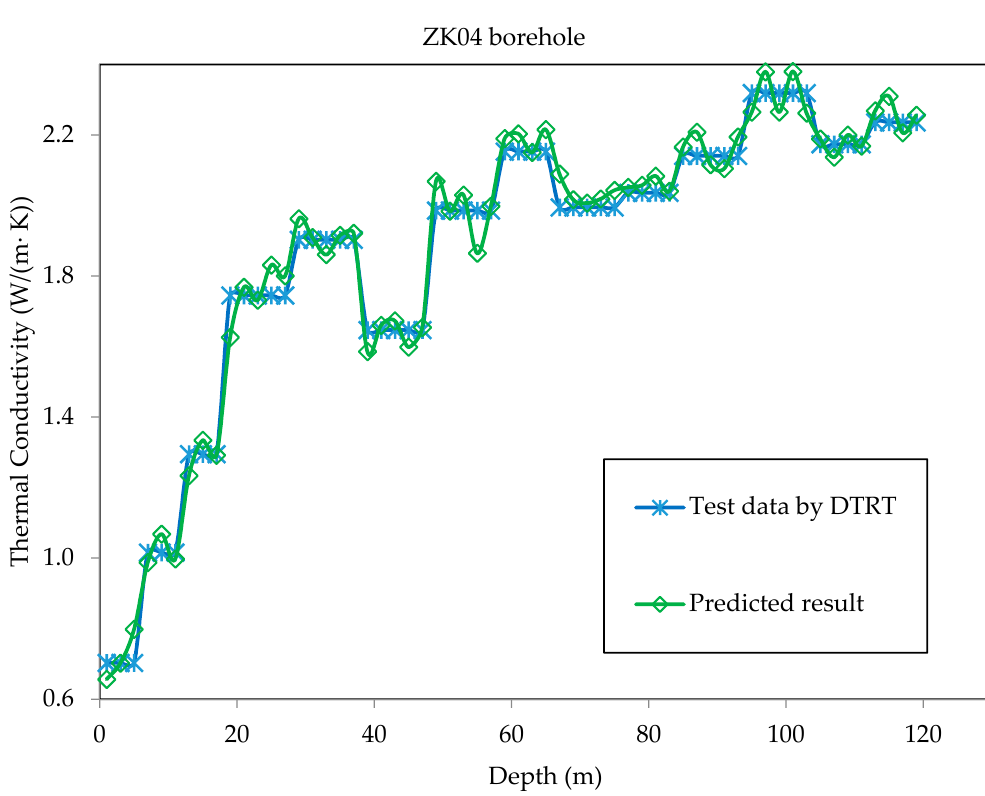
Figure 14. Prediction results of layered thermal conductivity for ZK04.